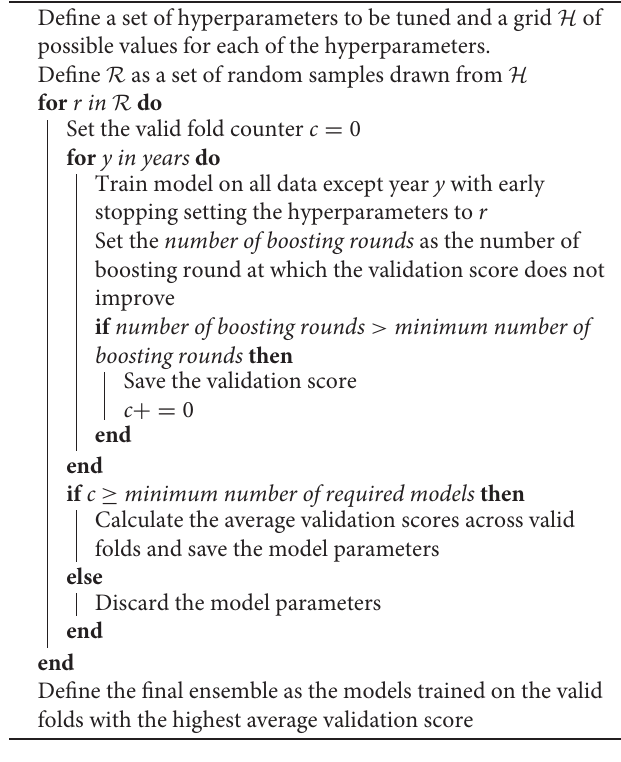
Algorithm 1: Model Training